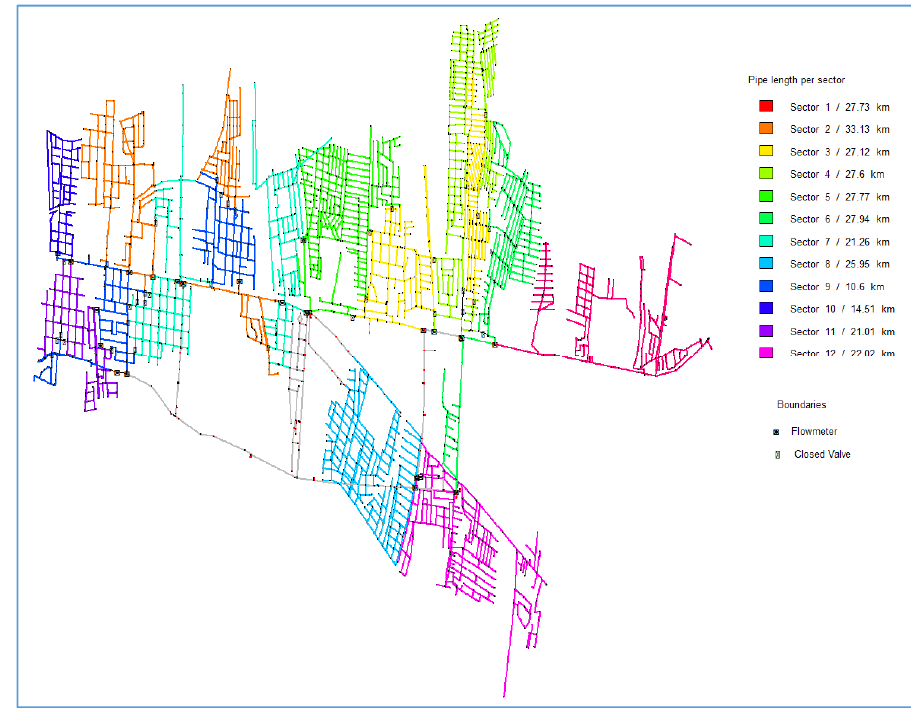
Figure 12. Final sectorization layout.